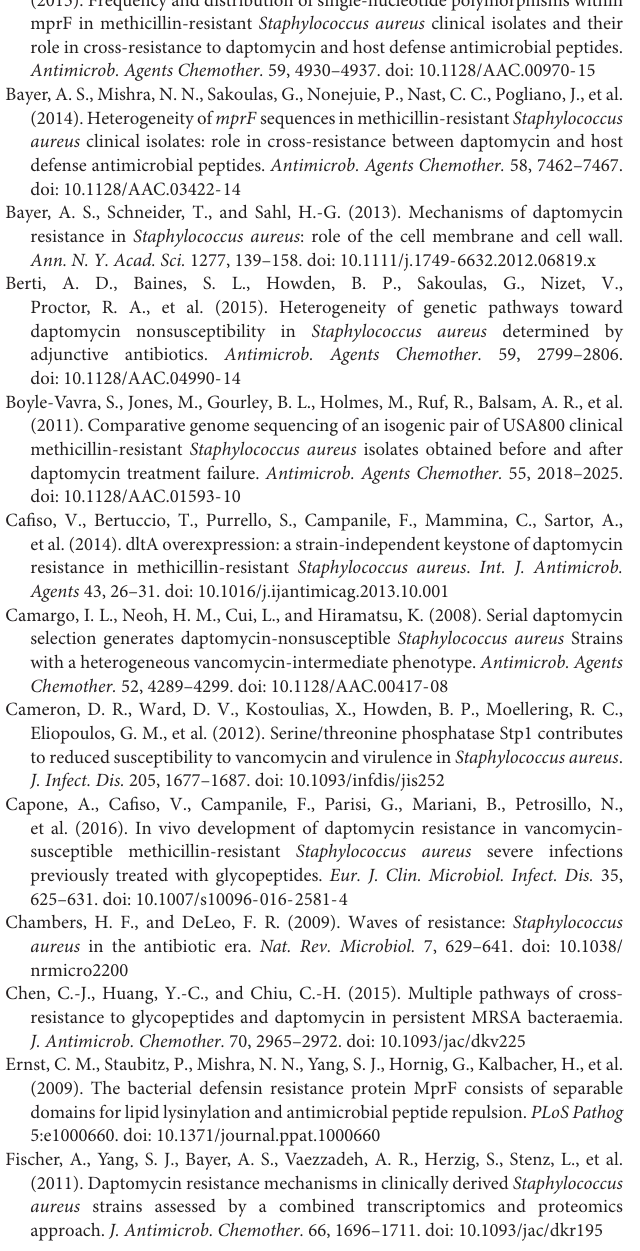
TABLE S2 | Allele Frequencies of SNPs for populations 6–8, population P and colonies 1–3 derived from population 6 at 6 µ g/ml and populations 7 and P at 10 µ g/ml daptomycin. Alt, Alternative (SNP) nucleotide frequency; Reads, total number of reads at a position. All concentrations are of daptomycin. No colonies were sequenced from Population C. TABLE S3 | SNPs present in colonies from Population A taken at 6 µ g/ml daptomycin and populations B and P at 10 µ g/ml daptomycin. Three colonies were sequenced from each population. SNPs present in the ancestral population are not